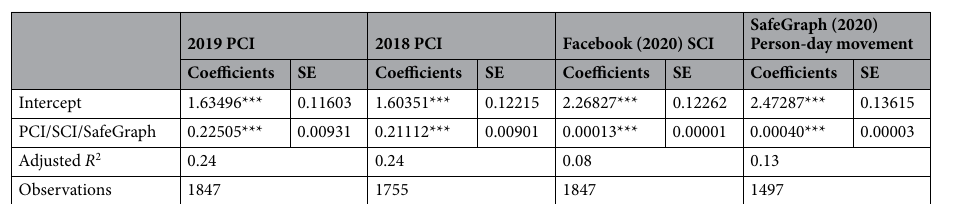
Figure 13. US county level COVID-19 cases per 10,000 people as of March 31, 2020. COVID-19 case data were downloaded from NYT Github 62 . The county population was retrieved from the ACS 5-year estimates (2014– 2018). The map was generated using ArcMap version 10.7.1.